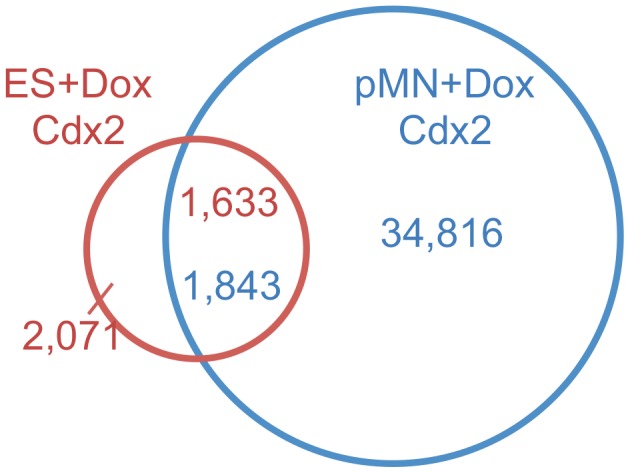
Binding event list comparison approaches to differential binding overestimate differences between binding site lists due to threshold effects and ignore true differences in enrichment between sites that are called bound in multiple conditions.The Venn diagram shows the overlap between ES+Dox and pMN+Dox binding events using a 200 bp overlap window. 1,633 ES+Dox Cdx2 events are within 200 bp of pMN+Dox events, while 1,843 pMN+Dox events are within 200 bp of ES+Dox events.